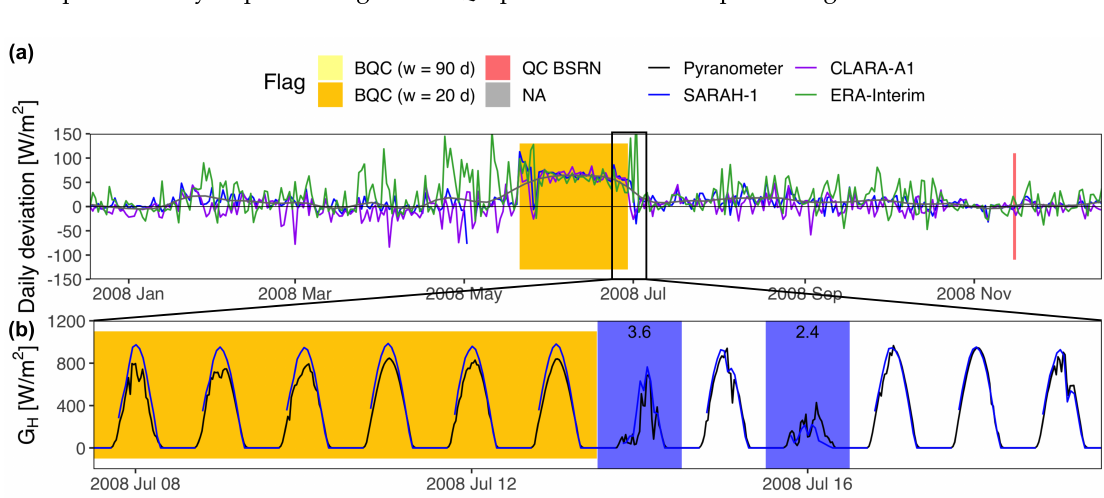
Figure 4. Accumulation of dust (soiling) over SIAR A12 pyranometer cleaned by the rain. ( a ) Daily deviations (estimations - measurements) of the radiation databases. The gray line is a smoother of the deviations from the three databases; ( b ) Instantaneous G H from SARAH-1 and the pyranometer. Days with precipitation are shaded in blue. The label shows the daily